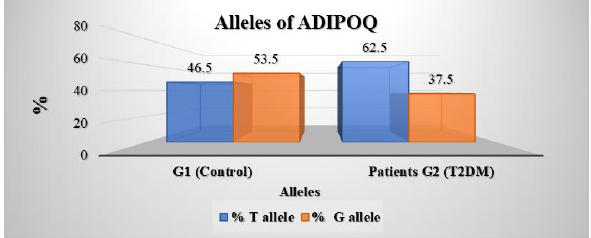
Fig. 3. The percentage of alleles T/G of ADIPOQ in blood samples of control, and T2DM patients. The genotype distribution of ADIPOQ rs2241766 (T>G) showed three polymorphisms: TT, TG, and GG. The values of the percentages of the first polymorphism TT were 32 %, and 41% for control, and T2DM patients, respectively. The values of the percentages of the second polymorphism TG were 29%, and 43% for control, and T2DM patients, respectively. The values of the percentages of the third polymorphism GG were 39 %, and 19% for control, and T2DM patients, respectively (“Figure 4”). The GG genotype was the major genotype at control, while the TG genotype was the major genotype at T2DM patients in rs 2241766 (ADIPOQ ).